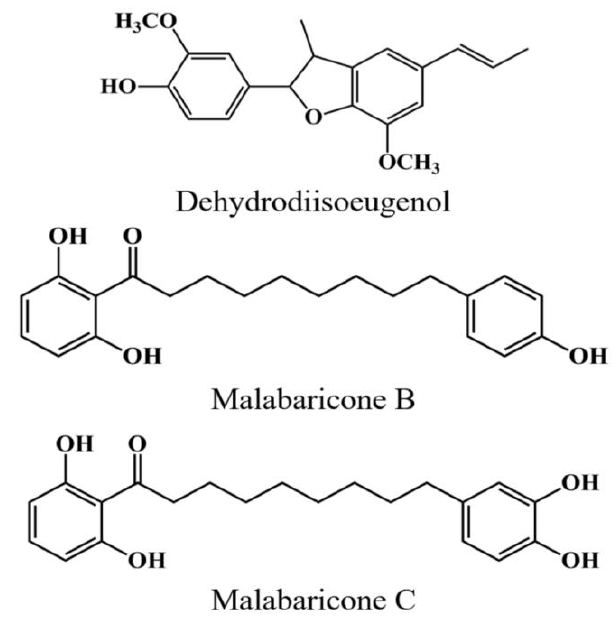
Figure 2. Chemical structures of three compounds from M. fragrans.